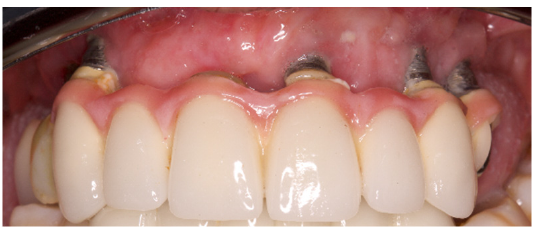
Figure 2. Silness and Löe plaque index (PI = 3 in 2.3 and 2.4, PI = 2 in 1.3 and 2.1).